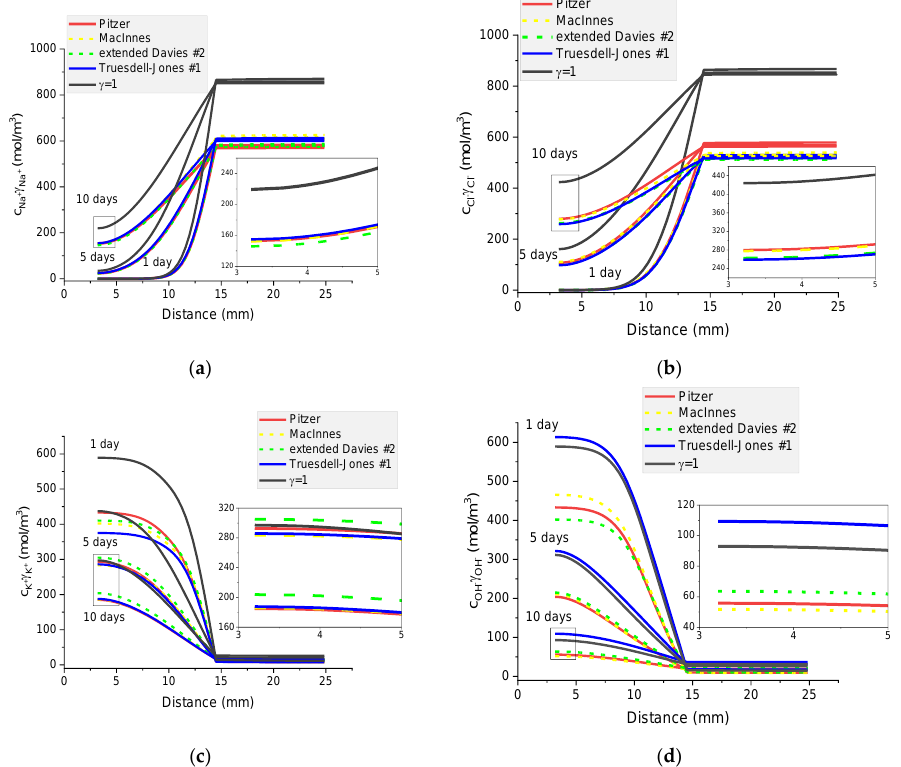
Figure 15. Calculated activities profiles of ions in the mortar immersed in 5 wt% NaCl water solu- tion. ( a ) Na + ; ( b ) Cl − ; ( c ) K; ( d ) OH − For the Pitzer model, MacInnes scaling, extended Davies and Truesdell – Jones models — comparison with ions concentrations ( γ = 1).